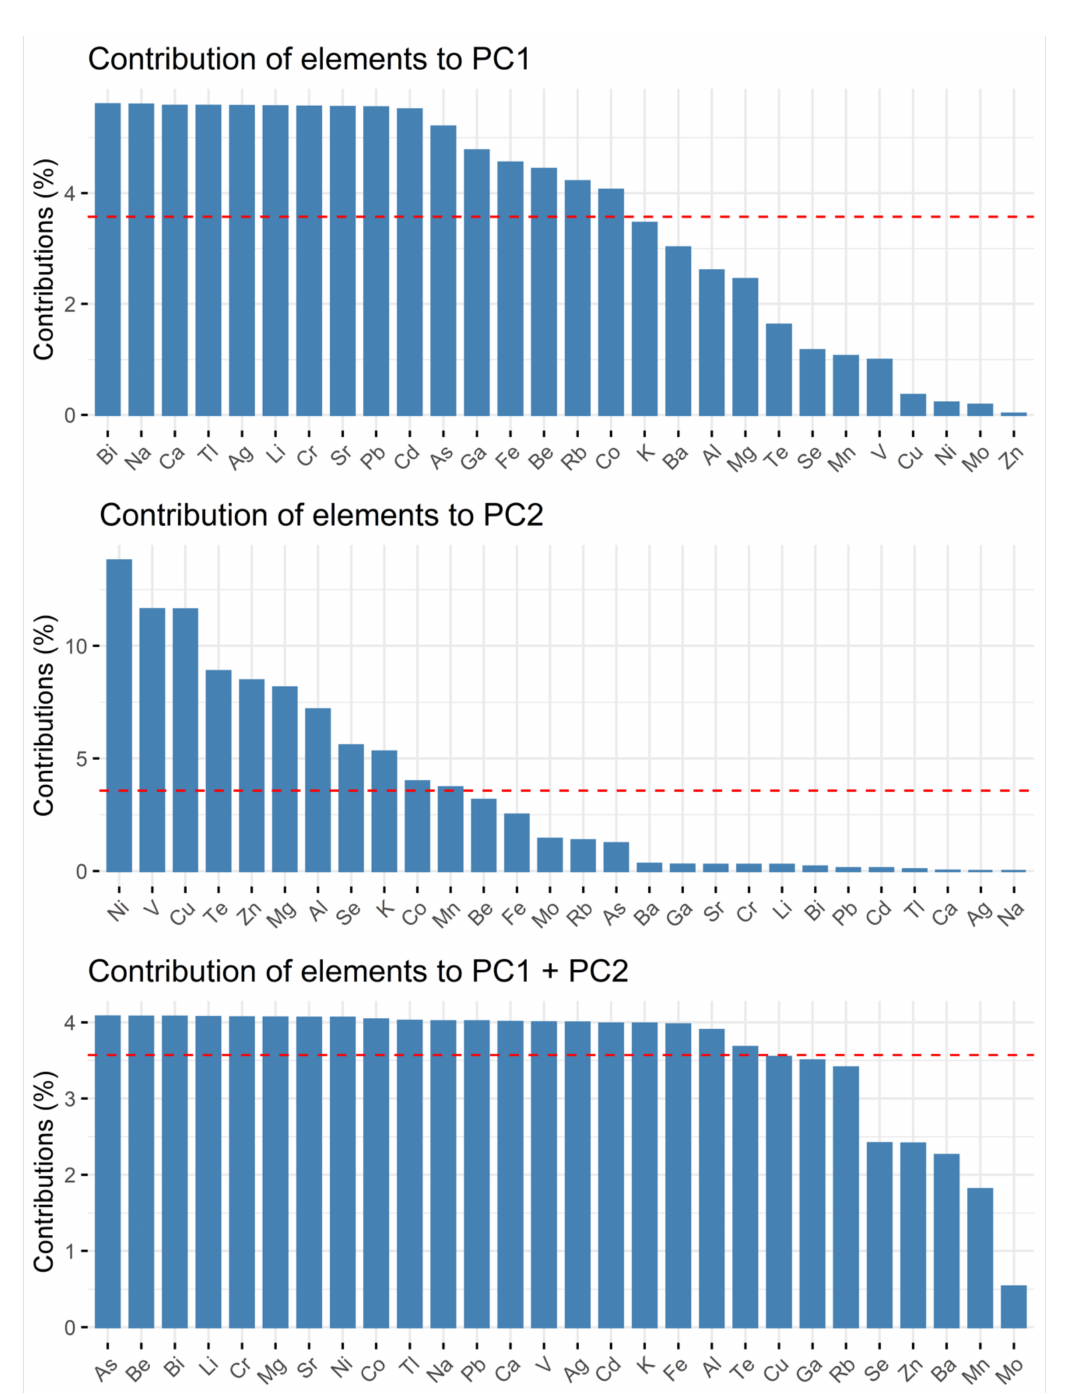
Figure 5. Contribution of elements to PC1 and PC2, red dashed line indicating average